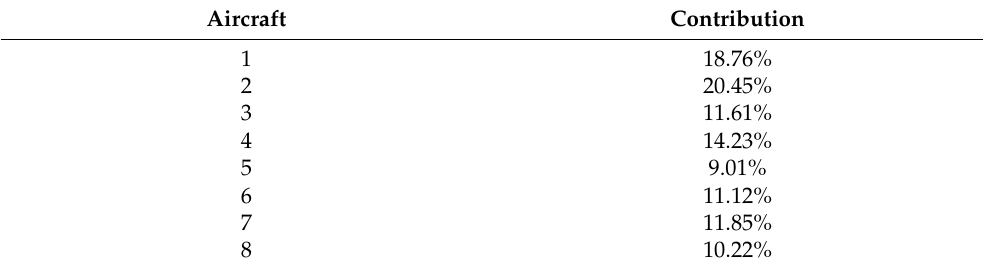
Figure 3. A more complex example. Nodes represent aircraft. Table 2. Contribution to complexity from each aircraft in Figure